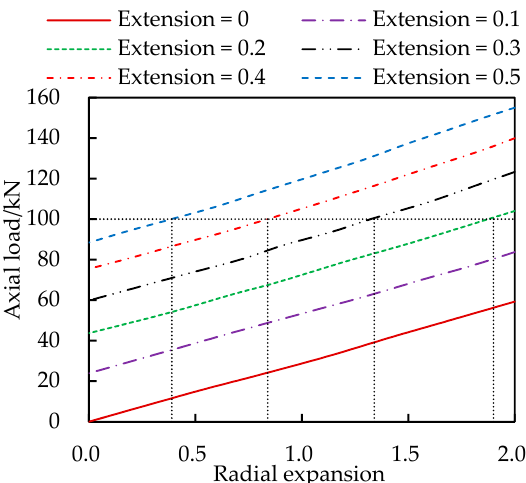
Figure 6. Possible deformation under specific internal pressure.